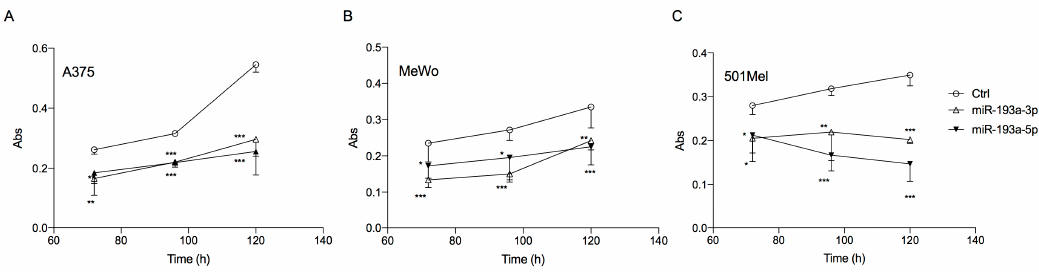
Figure 2. Ectopic over-expression of miR-193a arms reduces melanoma cell viability. Cell viability was analyzed by Neutral Red assay at different time points in A375 ( A ), MeWo ( B ), and 501Mel ( C ) cell lines. Data are representative of three independent experiments ± SD performed in triplicate. One-way ANOVA followed by Dunnett’s multiple comparisons test was performed; * p < 0.05, ** p < 0.01, *** p < 0.001 compared to the corresponding control.